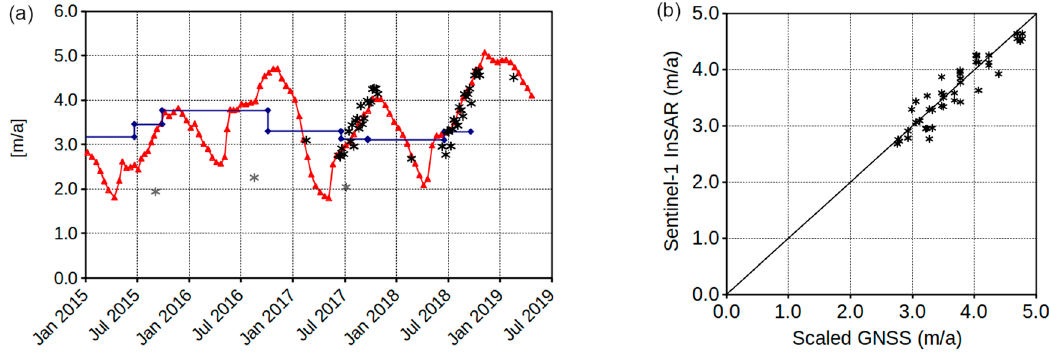
Figure 13. ( a ) 3D velocities using GNSS campaigns carried out seasonally (blue diamonds), 3D GNSS scaled velocities (factor 0.54) from the permanent station computed with the average daily positions corresponding to the acquisition dates of the Sentinel-1 acquisitions (red triangles) and velocity along the maximum slope direction from Sentinel-1 InSAR (grey 12 day time interval, black 6 day time interval) over the Tsarmine rock glacier (Val d’Arolla, Switzerland, for position see Figure 4a); ( b ) Scatter plot of the scaled GNSS and Sentinel-1 InSAR